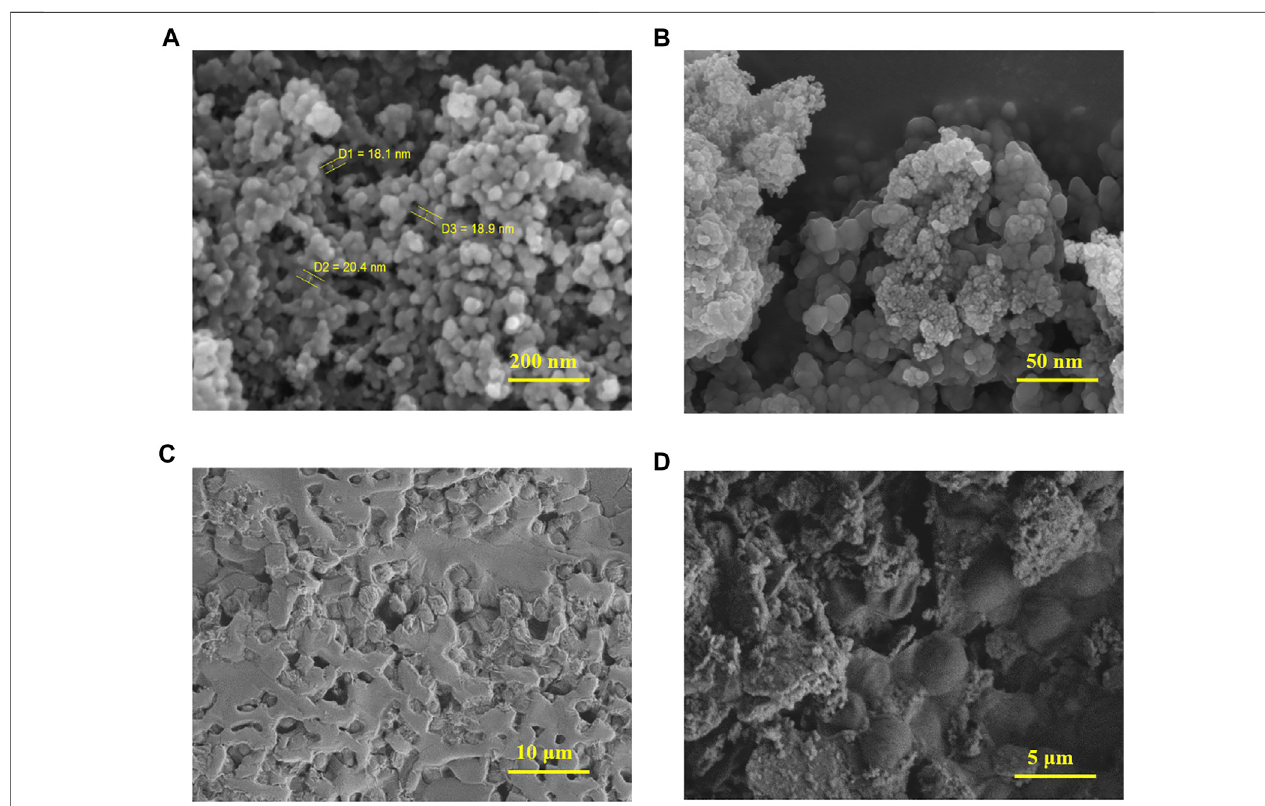
FIGURE10| Thescanningelectronmicroscopeimageof (A) nano-silica, (B) nano-silicaand (C) microbialcorrodedsiliconerubber, (D) microbialcorrodedsilicone rubber.